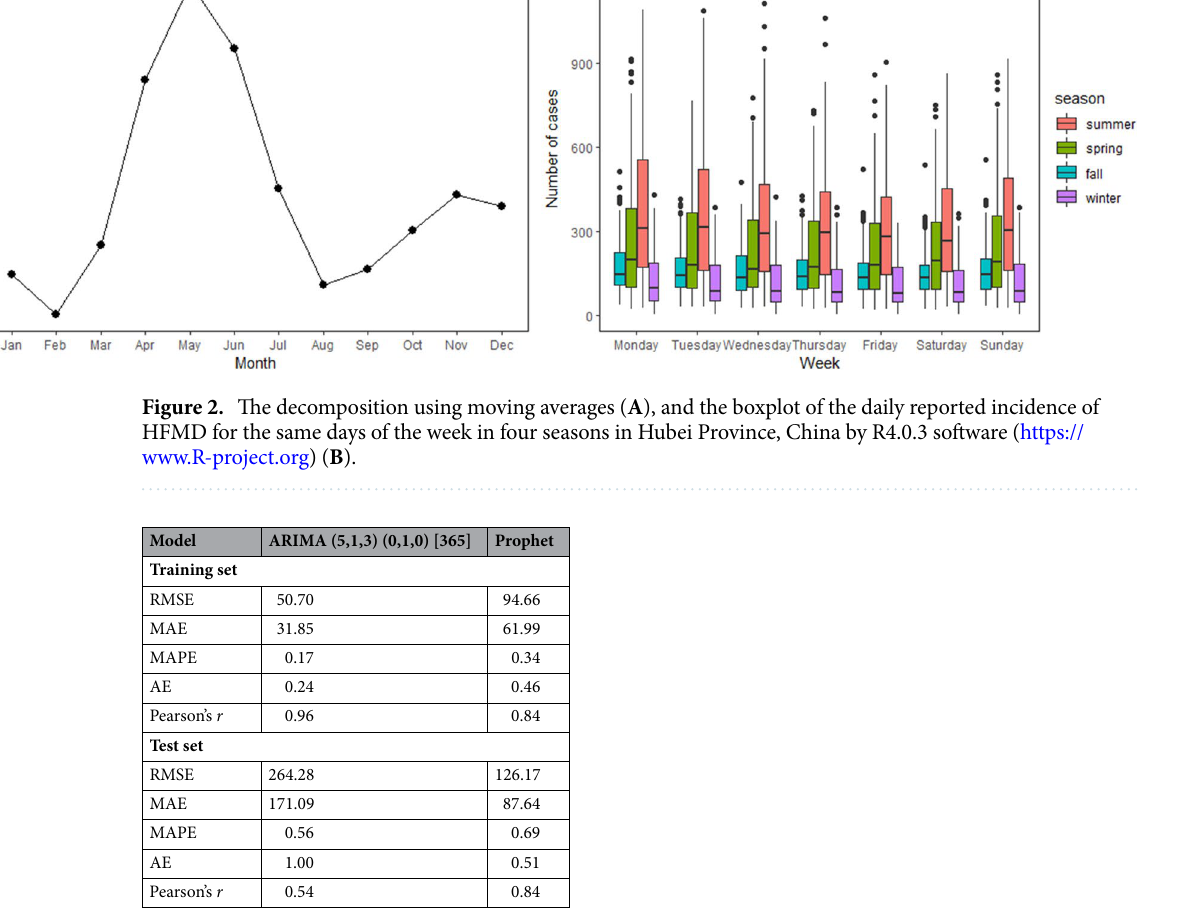
Table 1. RMSE, MAE, MAPE, AE and Pearson’s r values calculated in the training and test phases for the two models.